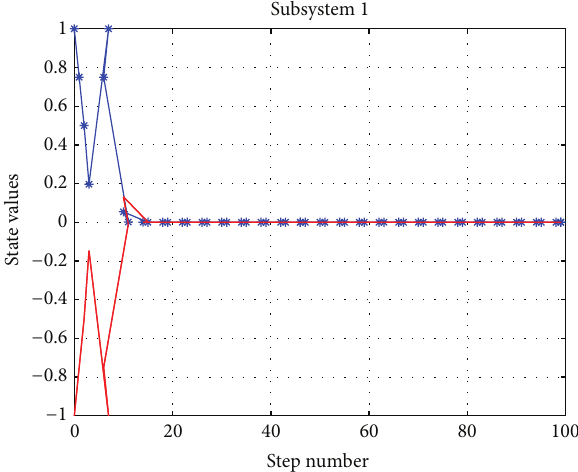
Figure 4: The state trajectories of subsystem 1. Figure 5: The state trajectories of subsystem